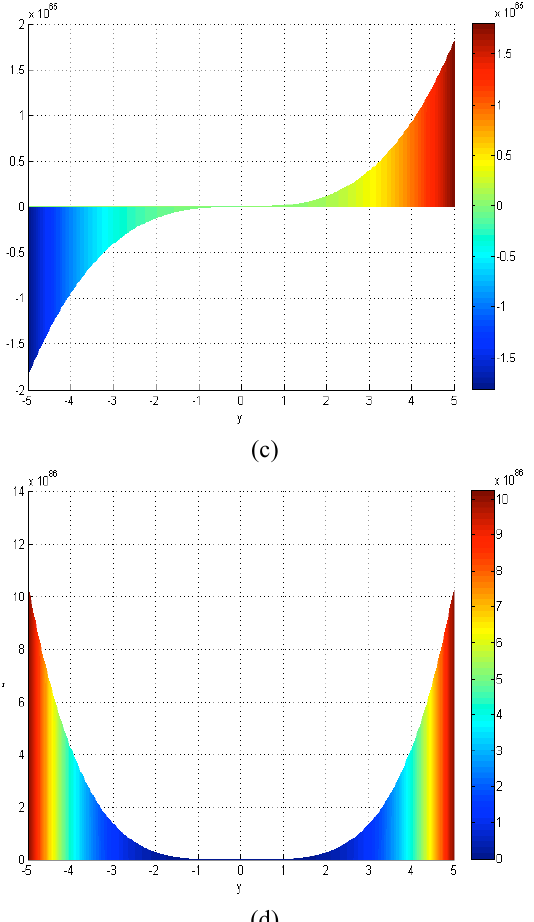
Figure 3: Distribution of the electric fields (a) j=1 , (b) j =2 (c) j=3 and (d)